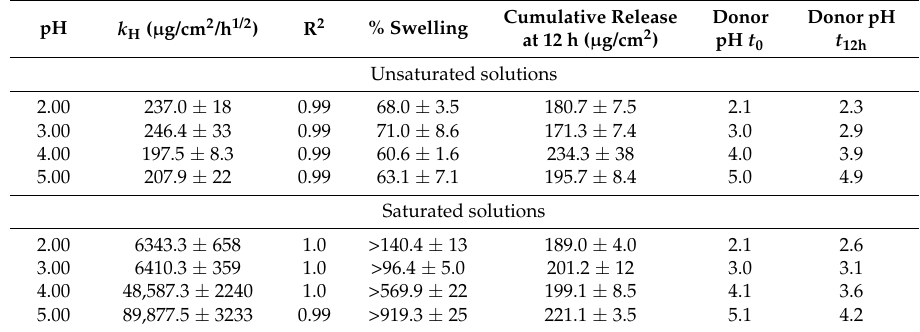
Table 2. Average values ± standard deviation ( n = 4) of k H , cumulative release in 12 h, % swelling and pH values of the donor phase in nitrocellulose membrane test